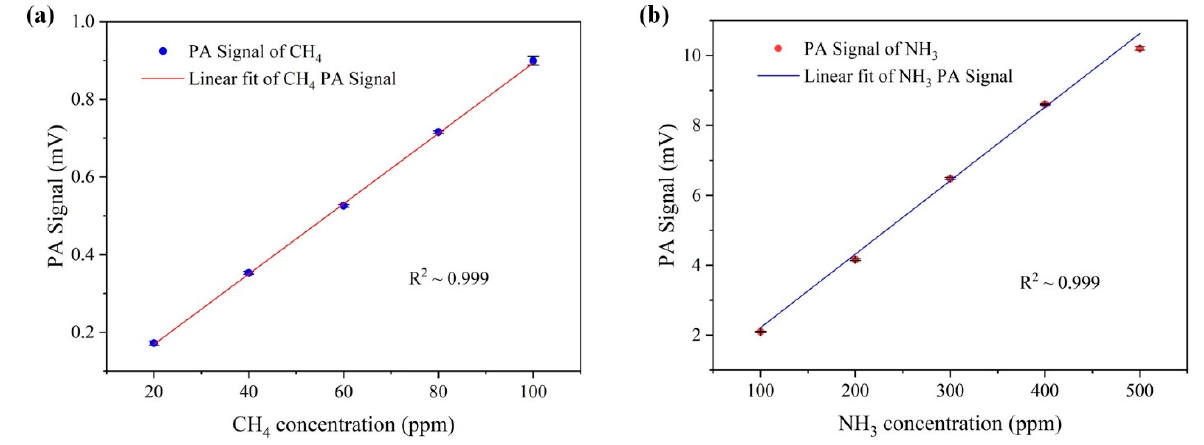
Figure 6. Calibration of CH 4 and NH 3 : ( a ) Response linearity of CH 4 at different concentrations. ( b ) Response linearity of NH 3 at different concentrations.